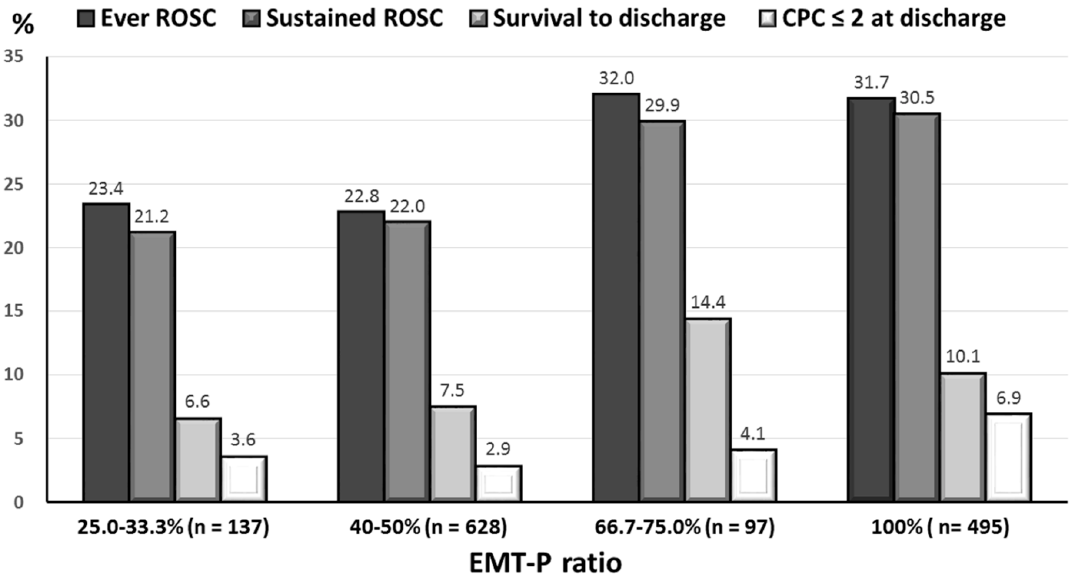
Figure 2. A positive EMT-P-related trend of the proportion of sustained ROSC), survival to discharge and CPC ≤ 2 at discharge. CPC = cerebral performance category; EMT-P = emergency medical technician-paramedic; ROSC = return of spontaneous circulation. Table 1. Demographic data and outcomes of enrolled out-of-hospital cardiac arrest patients stratified by the EMT-paramedic ratio.